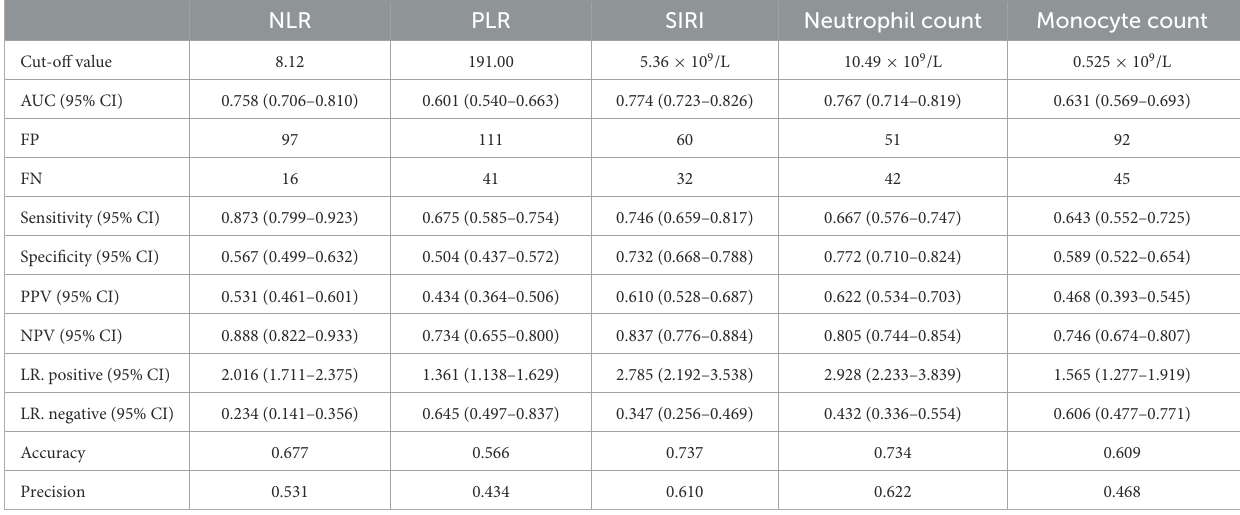
(95% CI: 0.723–0.826) as this was the largest among